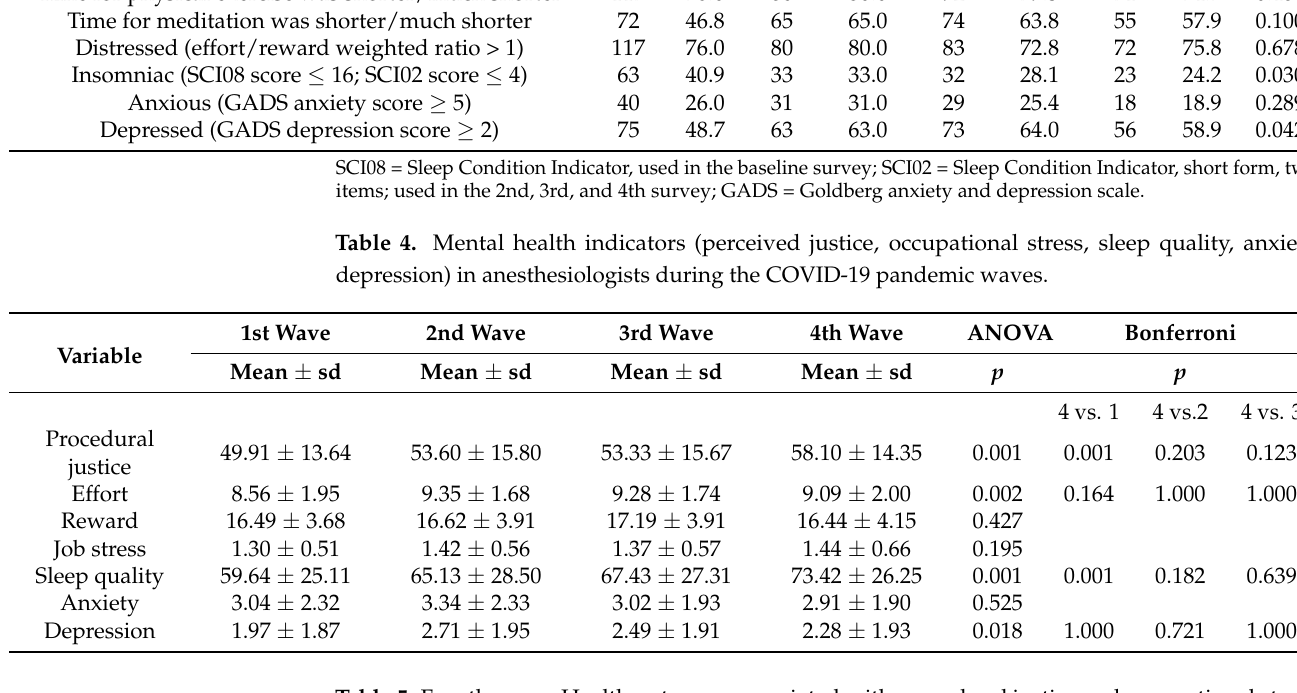
Table 5. Fourth wave. Health outcomes associated with procedural justice and occupational